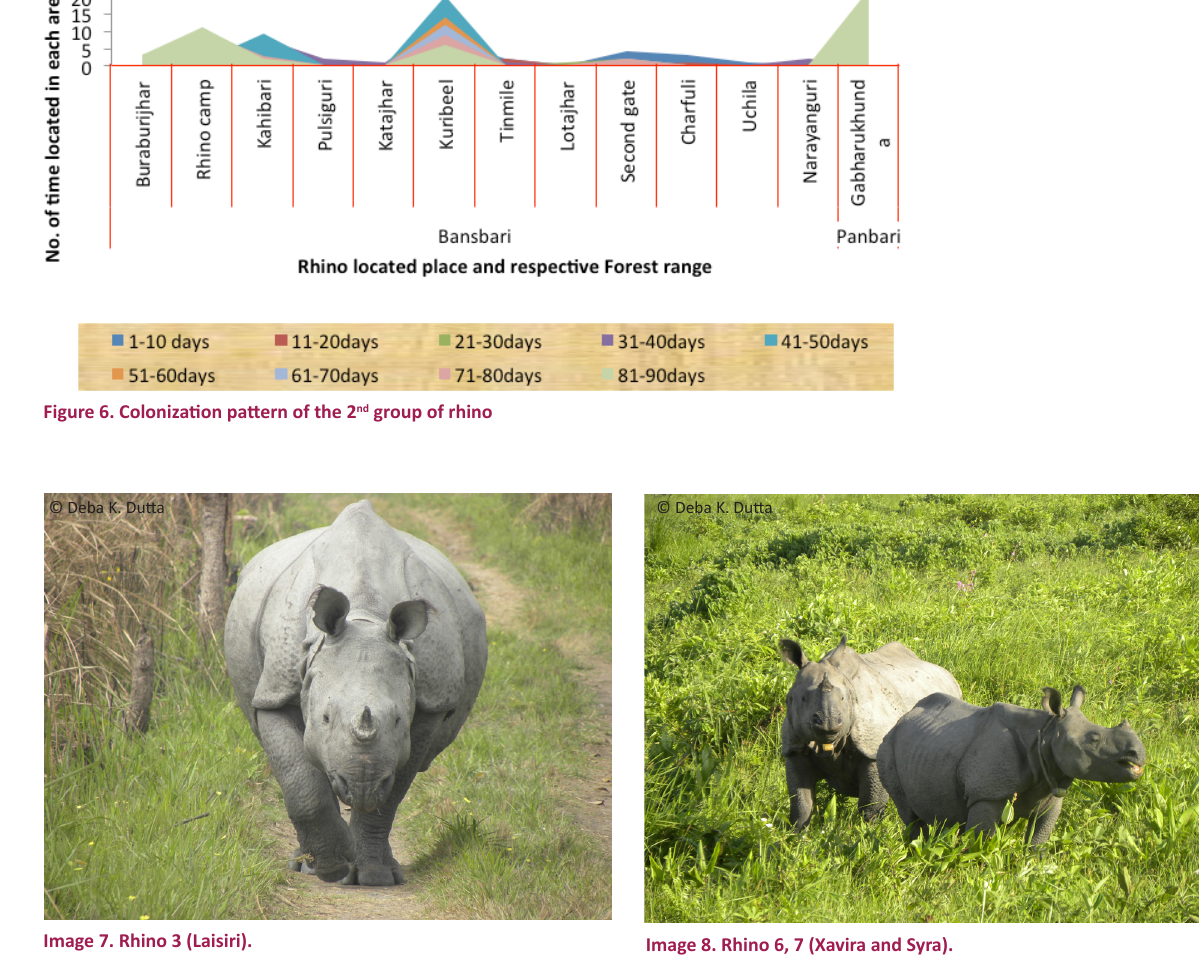
Image 8. Rhino 6, 7 (Xavira and Syra). Image 7. Rhino 3 (Laisiri).